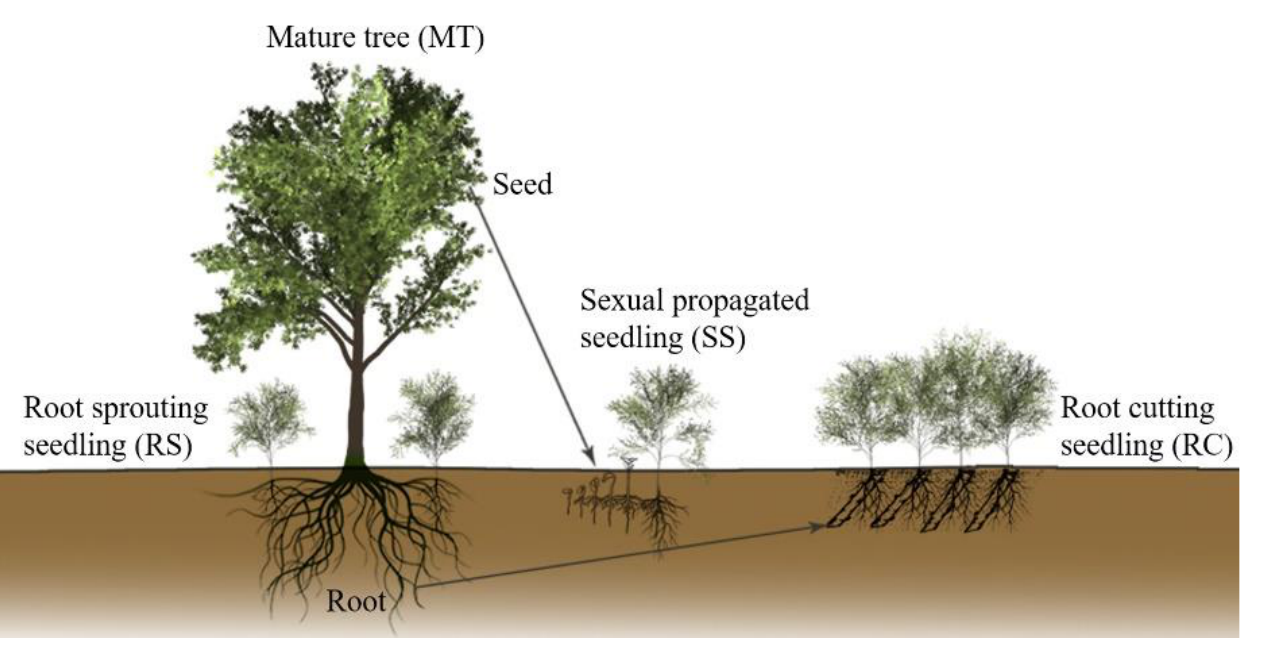
Figure 1. Schematic drawing of a mature tree and its seedlings. Root sprouting seedlings (RSs) and root cutting seedlings (RCs) were propagated asexually from the roots of mature trees (MTs). Sexually propagated seedlings (SSs) developed from half-sibling seeds of MTs.